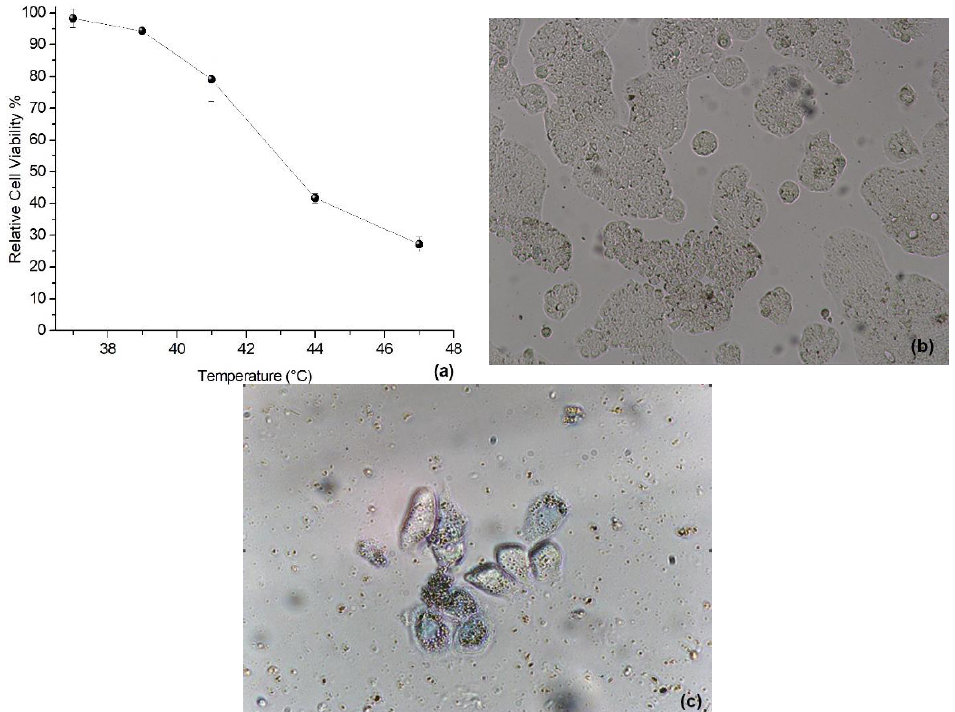
Figure 9. ( a ) Cytotoxic effect on HT-29 cells when they were exposed to 2.0 mg/mL NMP-GA and MFH at different temperatures. Cells stained with trypan blue after the exposition to MNP-GA2, 2.0 mg/mL, and MFH at different temperatures: ( b ) Growth control at 37 °C (10× magnification) and ( c ) Cells heated at 47 °C (40× magnification).